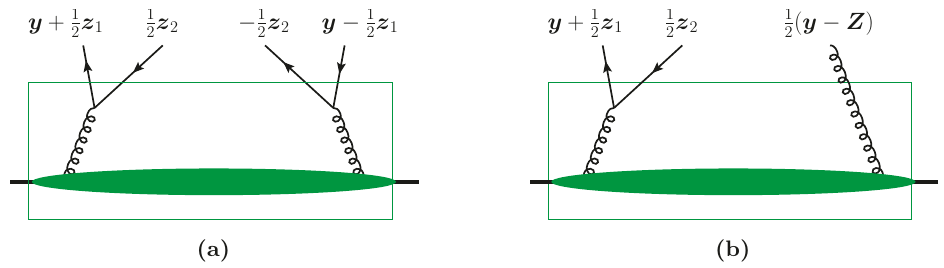
Figure 6. Transverse positions of the parton fields in parton splitting contributions to (a) the quark-antiquark DTMD and (b) the twist-three TMD D q . Due to translation invariance, the ¯ q | g latter depends only on y and Z . The positions in (b) correspond to equation (3.9) in [30]. + are inserted in the interference σ + σ between SPS and DPS. The SPS DPS/SPS SPS/DPS